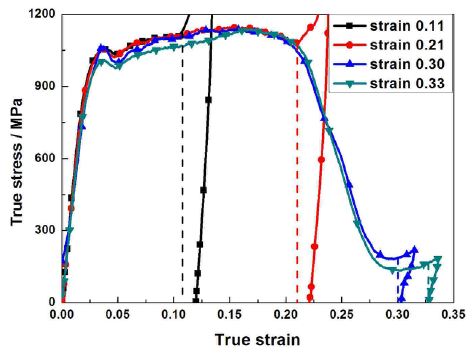
Fig. 1. Stress-strain curve of zirconium alloy impacted by a SHPB at a strain rate of 2300 s -1 .